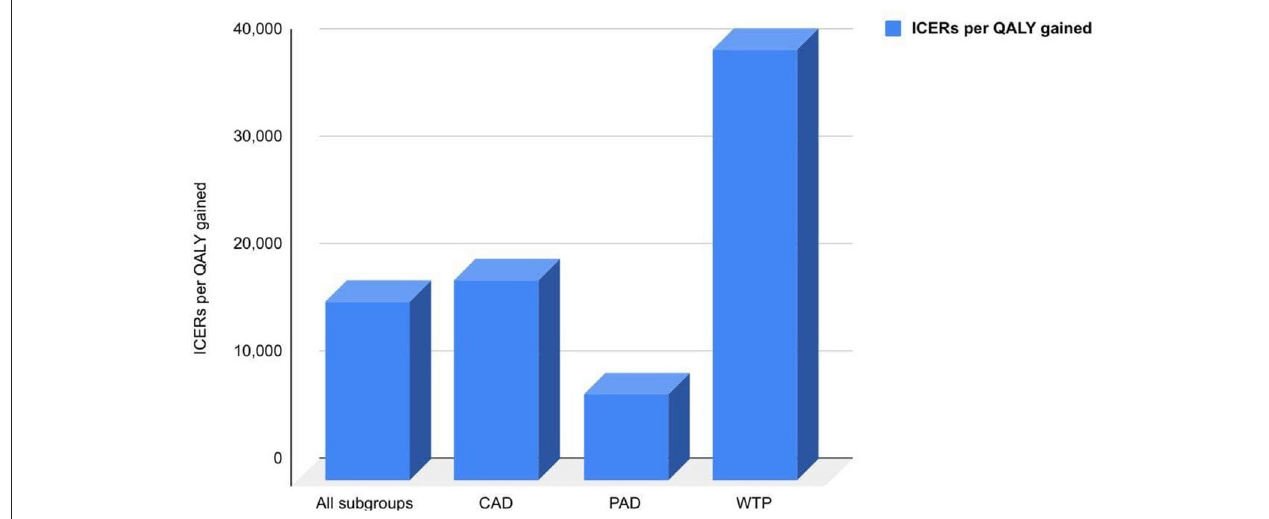
FIGURE 1 | ICERs per QALY gained in different patient subgroups compared to the WTP of the